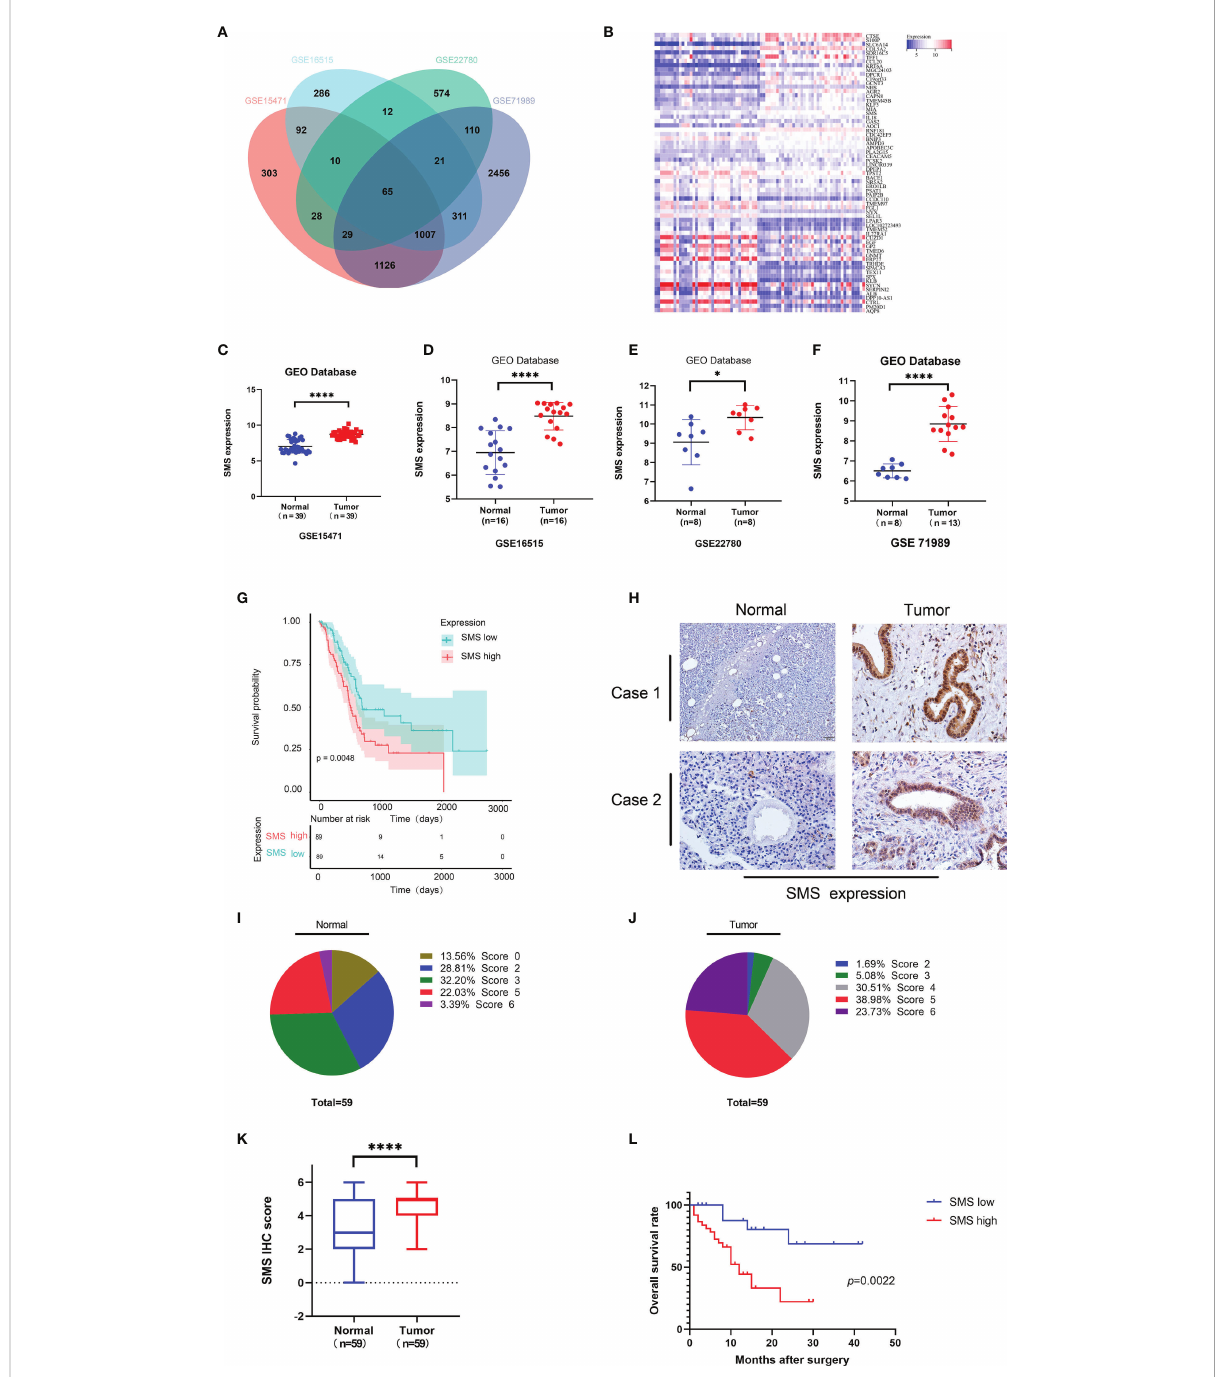
FIGURE 1 The expression and prognostic value of SMS in human pancreatic cancer. (A) Coincidence of differential Genes in GSE15471, GSE16515, GSE22780, and GSE71989 from GEO database. (B) The heat map of up-regulated genes and down-regulated genes in overlapping genes. (C-F) Expression level of SMS in pancreatic tumor and adjacent normal tissues from GEO database were analyzed. (G) Kaplan – Meier analyses of SMS high expression and low expression were analyzed from the TCGA database. (H-K) The expression of SMS in 59 paraf fi n embedded specimens from the internal cohort was determined by IHC staining. Representative IHC images are shown (H) , and the relative SMS staining intensity was scored (I-K) . Scale bar, 200 m m. (L) Kaplan – Meier analyses of the correlations between SMS expression and overall survival of all PDAC patients. *P < 0.05; ****P <